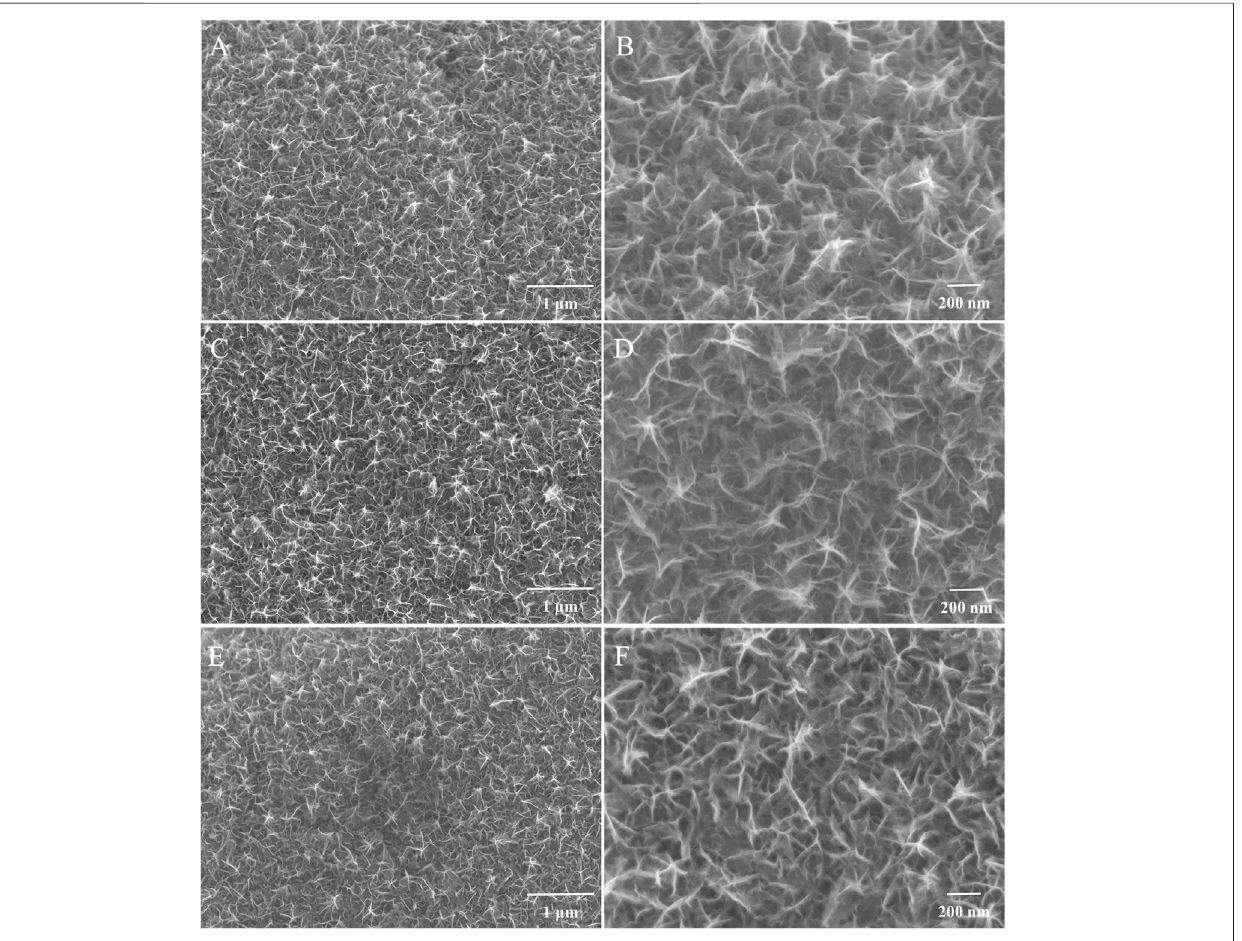
FIGURE 1 | SEM images of (A,B) MnO 2 ; (C,D) MnO 2-x ; and (E,F) Cr 2 O 3 /MnO 2-x .